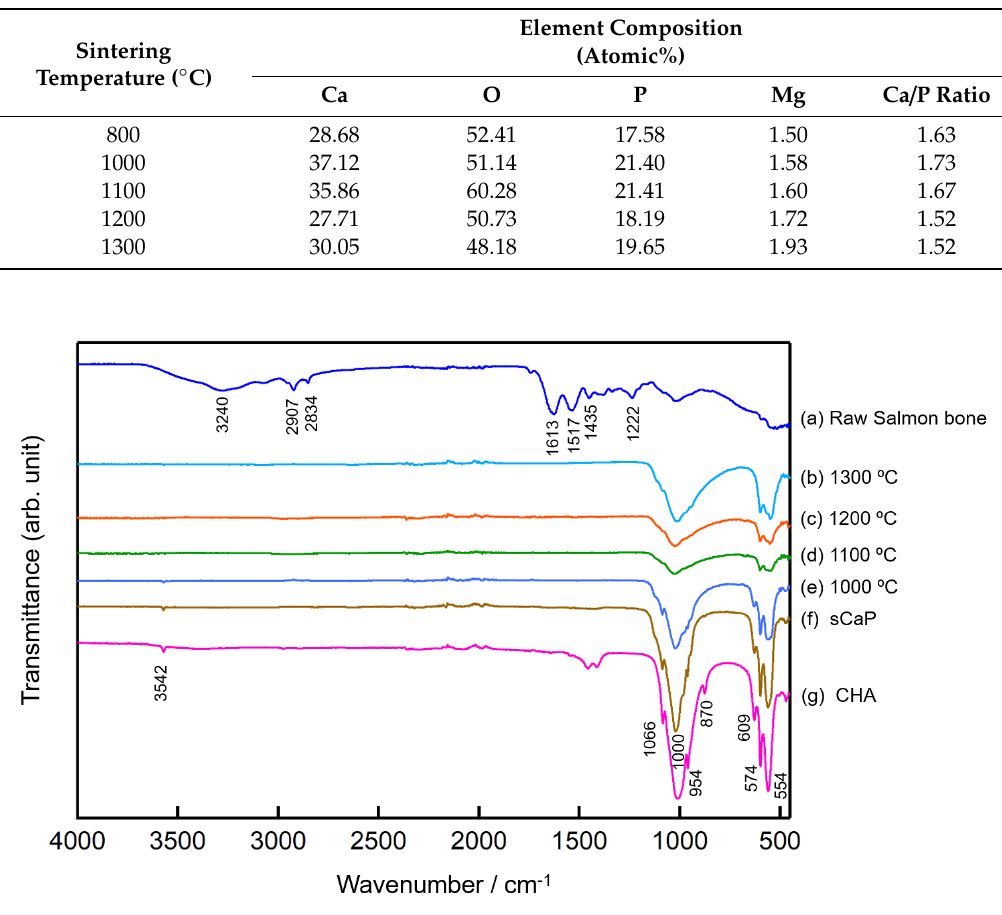
Figure 6. FTIR spectra; ( a ) raw salmon bone, ( b ) sintered sCaP at 1300 °C, ( c ) sintered sCaP at 1200 °C, ( d ) sintered sCaP at 1100 °C, ( e ) sintered sCaP at 1000 °C, ( f ) 800 °C sCaP and ( g ) CHA.